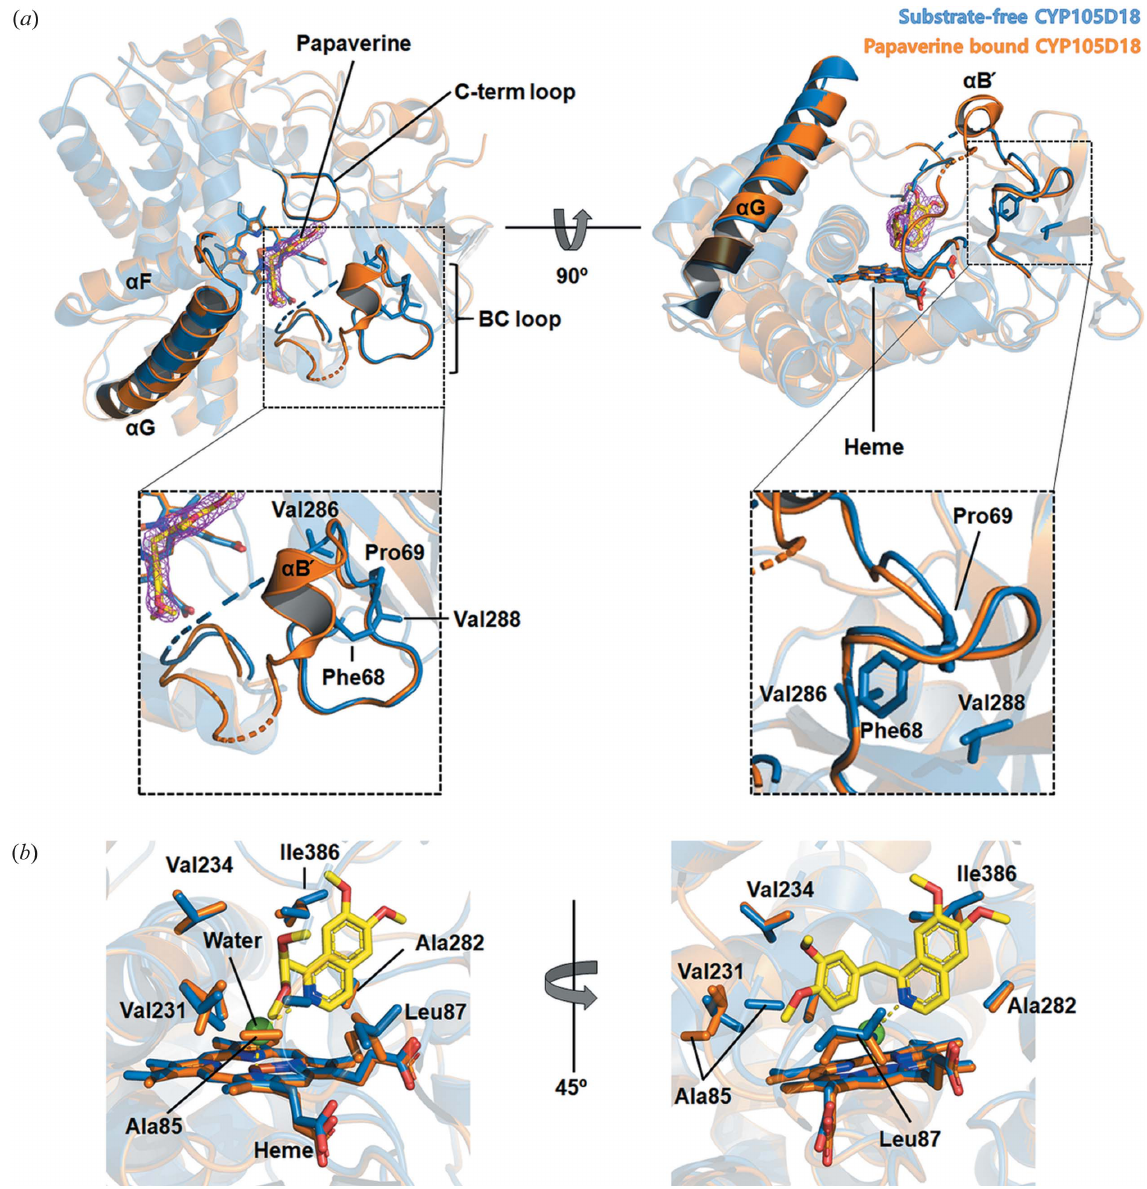
Figure 7 Structural comparison of the substrate-free structure and papaverine complex with CYP105D18. ( a ) Superposition of substrate-free CYP105D18 with papaverine-bound CYP105D18 colored blue and orange, respectively. The BC loop and turn of (cid:3) F– (cid:3) G of CYP105D18 are shown as ribbon diagrams. ( b ) Close-up view of the (cid:3) B 0 and hinge region of the active site. ( c ) Close-up view of the heme and papaverine-binding site. The papaverine and interacting residues are shown as stick models. Yellow stick models indicate papaverine. Bound heme molecules are also indicated by stick